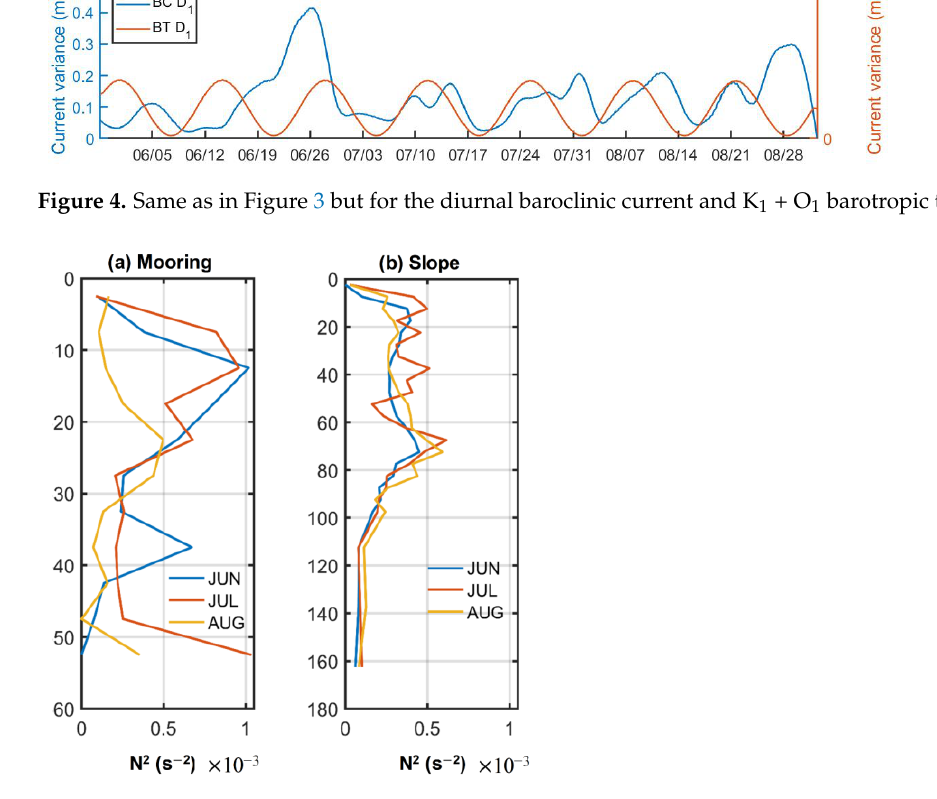
Figure 5. Comparison of monthly buoyancy frequency profiles from mooring ( a ) and slope ( b ).